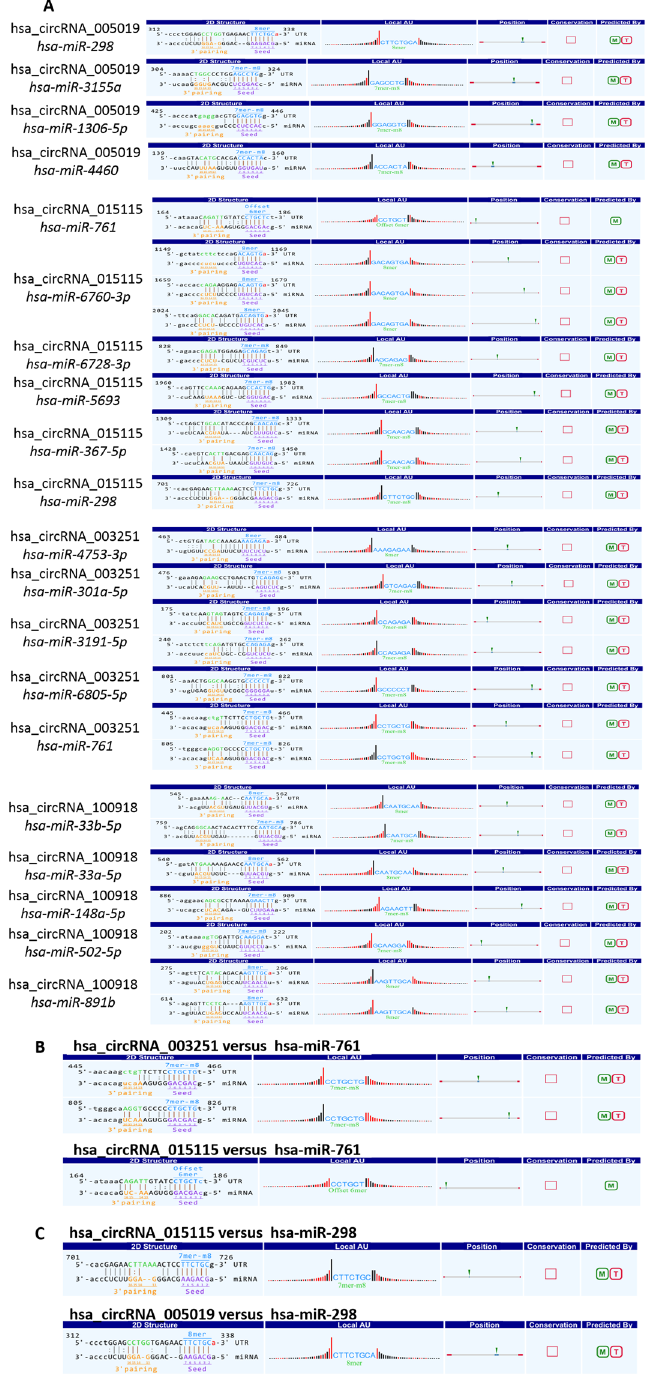
Figure 3. Relationships between four circRNAs and their target microRNAs. ( A ) MiRNAs targeted by hsa- circRNA _005019, hsa- circRNA _015115, hsa- circRNA _003251, and hsa- circRNA _100918. ( B ) hsa- miR-761 matched with hsa- circRNA _003251 and hsa- circRNA _015115. ( C ) hsa-miR-298 matched with hsa- circRNA _015115 and hsa- circRNA